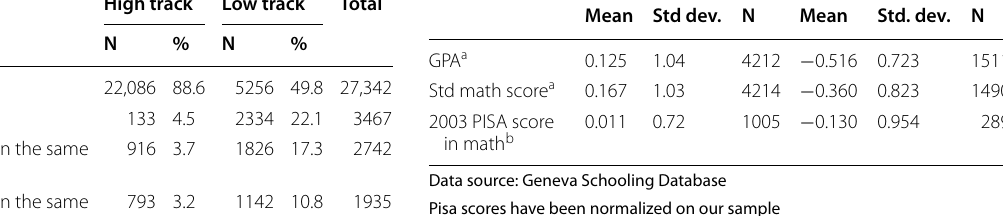
Data source: Geneva Schooling